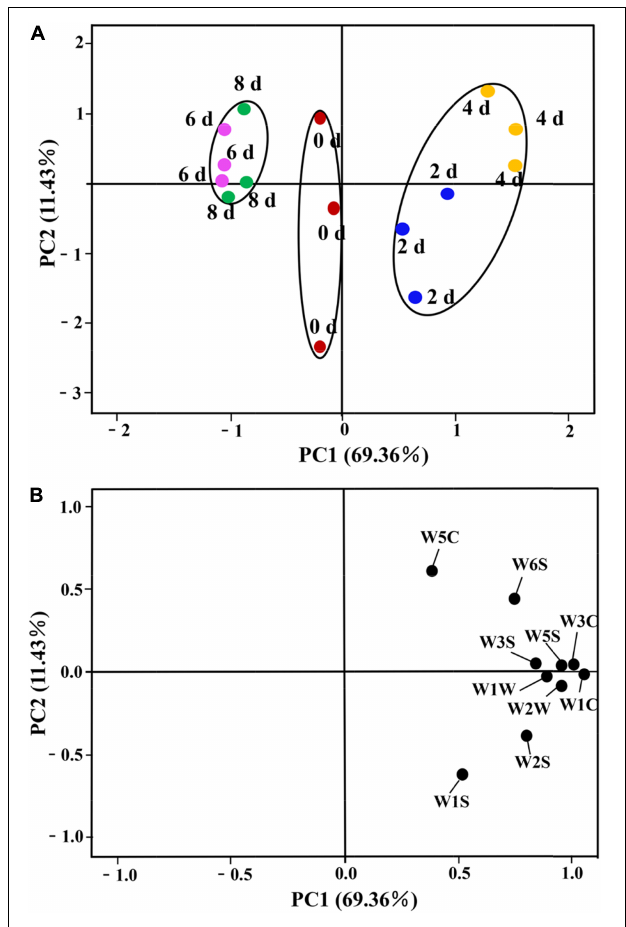
FIGURE 3 | Principal component analysis (PCA) of cut lilies during the postharvest process based on E-nose date. (A) Score plot; (B) loading plot.